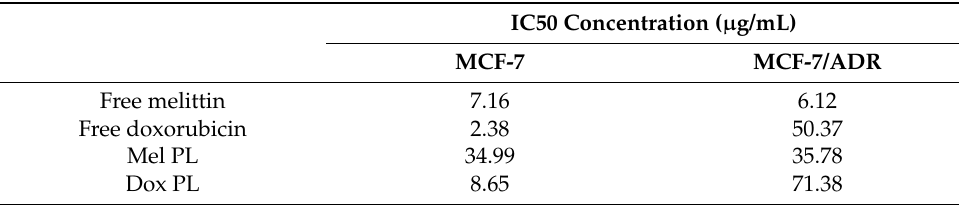
Figure 6. Combination index analysis. Combination index (CI) of <1 indicated that all combinations were highly synergistic against MCF-7/ADR cells. The CI of different ratios of drug combination. Based on IC 50 of the two drugs, 1/8, 1/4, 1/2, 1, and 2 were treated to experiment. ( A ) Treatment with free doxorubicin – melittin in MCF-7/ADR cells. ( B ) Treatment with Dox-Mel PL in MCF-7/ADR cells. Table 1. IC 50 of melittin and doxorubicin in MCF-7 or MCF-7/ADR